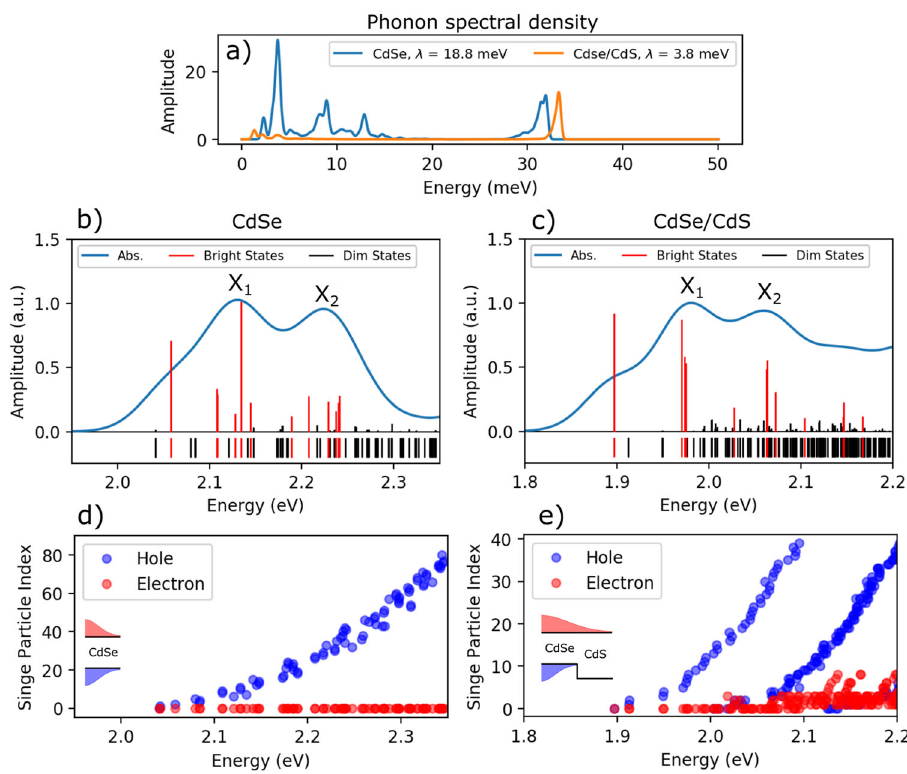
Fig. 5 Atomistic calculations of exciton and phonon states as well as exciton – phonon couplings in CdSe quantum dots (QDs) and CdSe/CdS QDs. a The calculated phonon spectral density for CdSe QDs (blue) and CdSe/CdS QDs (orange) shows stronger exciton – phonon coupling for CdSe QDs. Calculated linear absorption spectra of ( b ) CdSe QDs and c CdSe/CdS QDs, featuring “ bright states ” with stronger oscillator strength (red) and “